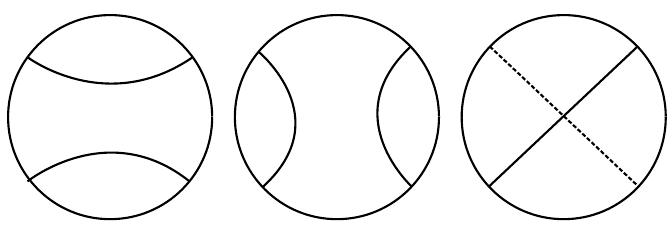
Figure 1 . Possible Witten diagrams for the disconnected correlator at order 1 =c 0 . When p 6 = q , only the (cid:12)rst diagram contributes. For p = q , the two other diagrams can appear. See eq. (3.1). obtain the functions f and H at strong coupling, by computing their double-discontinuity and using the inversion integrals (2.28) and (2.30) to (cid:12)nd the expansion coe(cid:14)cients (2.17) and (2.19). This method eschews the use of nonrenormalization theorems and detailed knowledge of superconformal